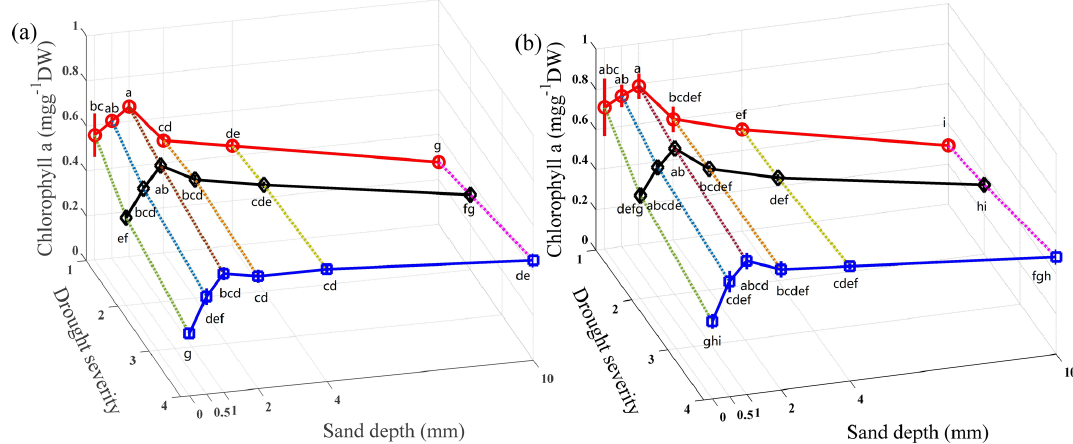
Figure 2. Changes in the chlorophyll a content of the biocrust moss Bryum argenteum Hedw. following exposure to natural precipitation (control; 1), half of the natural precipitation amount (2), and one-fourth of the natural precipitation amount (4), combined with 0 (control), 0.5, 1, 2, 4, and 10mm depth of sand burial in spring (a) and autumn (b) . Symbols represent means ± SE. Different letters indicate significant differences between different drought severities and sand burial depth treatments at the p < 0 . 05 level, as determined using an LSD post hoc test.